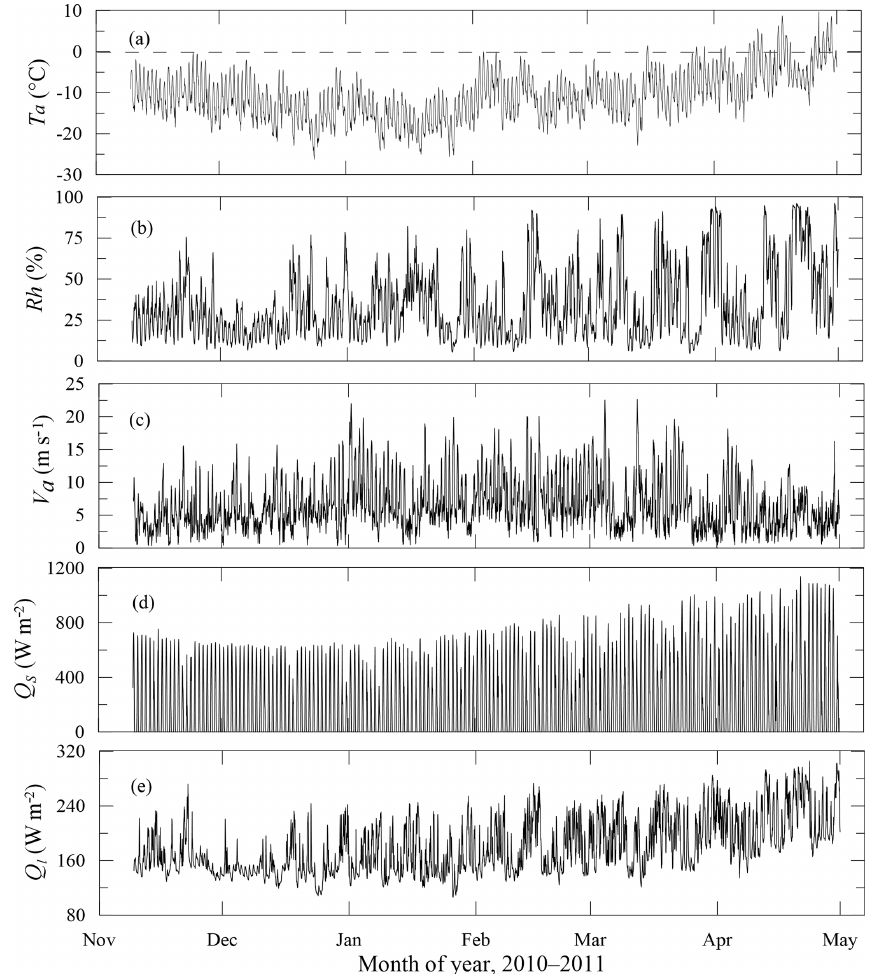
Figure 3. The time series of observed meteorological variables through the whole ice season of 2010–2011. (a) Daily mean air temperature T a , (b) relative humidity Rh, (c) wind speed V a , (d) incident short-wave solar radiation Q s , and (e) incident long-wave radiation Q l